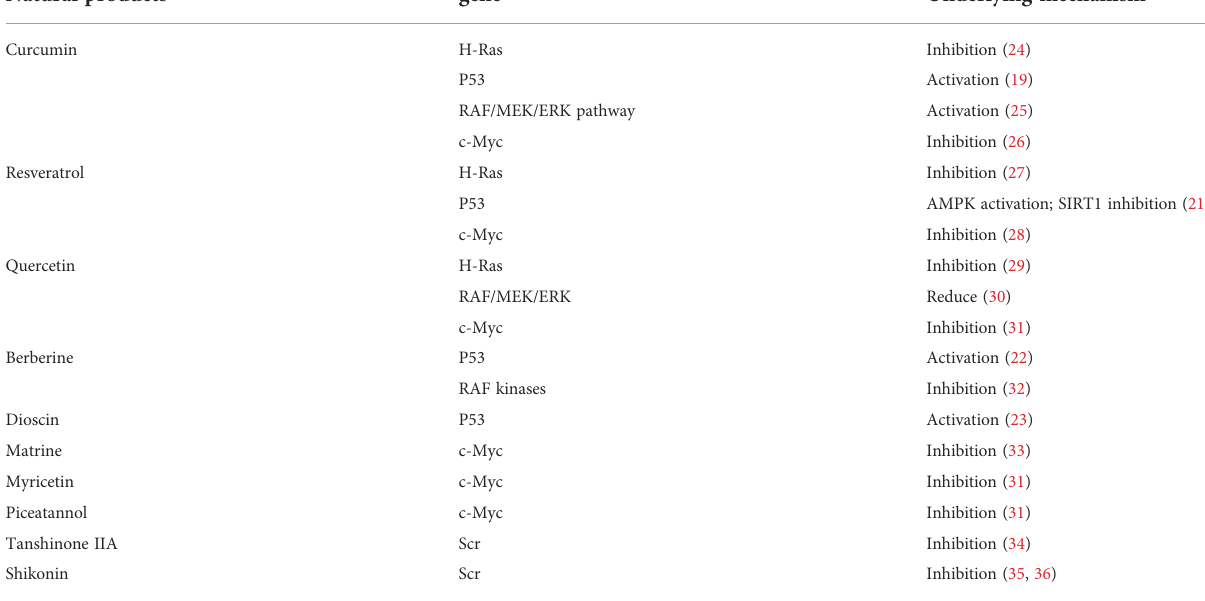
TABLE 1 Genetic mechanisms underlying natural products-based cancer treatment. Natural